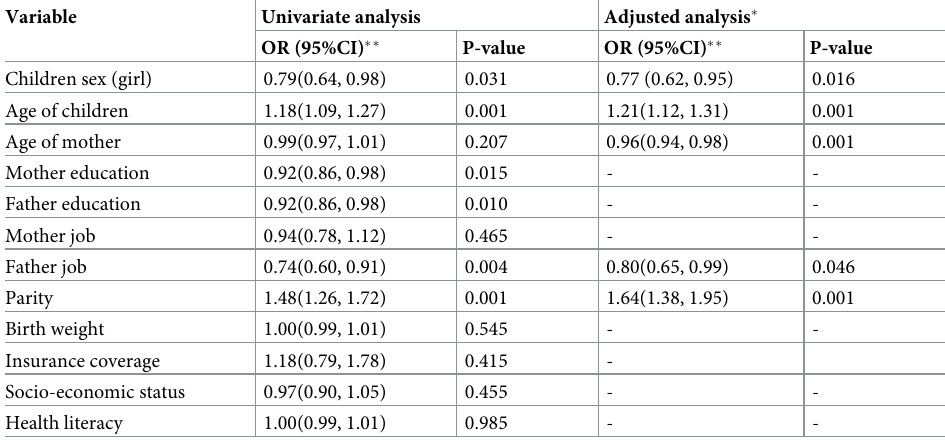
Table 2. Association between maternal self-medication of antibiotics for children and independent variables in univariate and adjusted logistic regression analysis among children 0–5 years old,